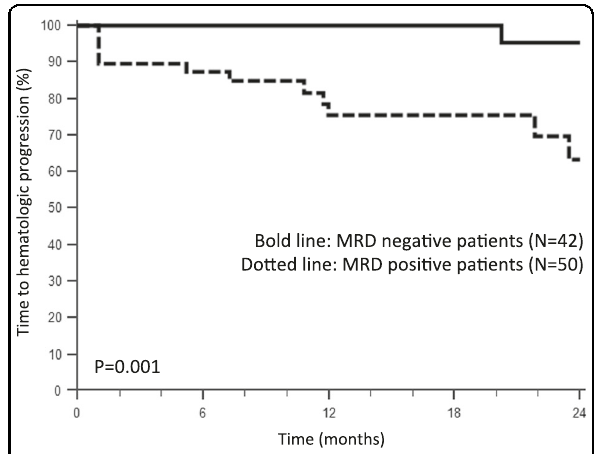
Fig. 1 Maintenance of amyloid complete response after MRD assessment according to MRD status. Bold line: MRD negative patients ( N = 42). Dotted line: MRD positve patients ( N =